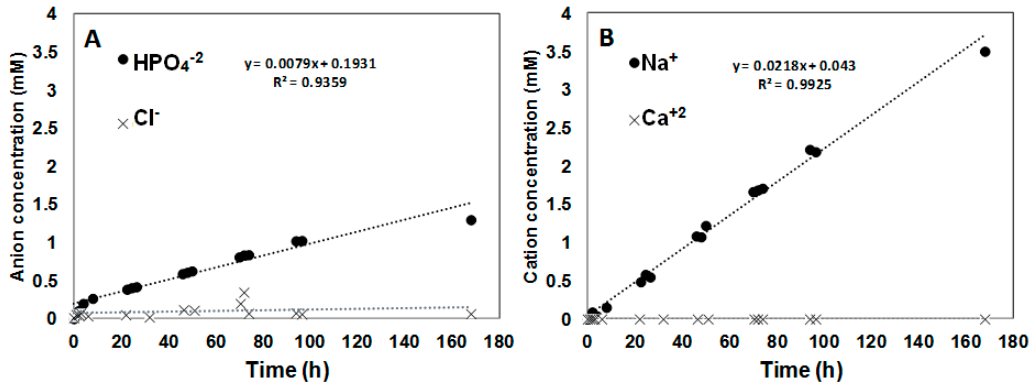
Figure 9. Time courses for the anions (A) and cations (B) of each nutrient in the receiving phase using a PILIM based on 70% w / w of [MTOA + ][Cl − ].